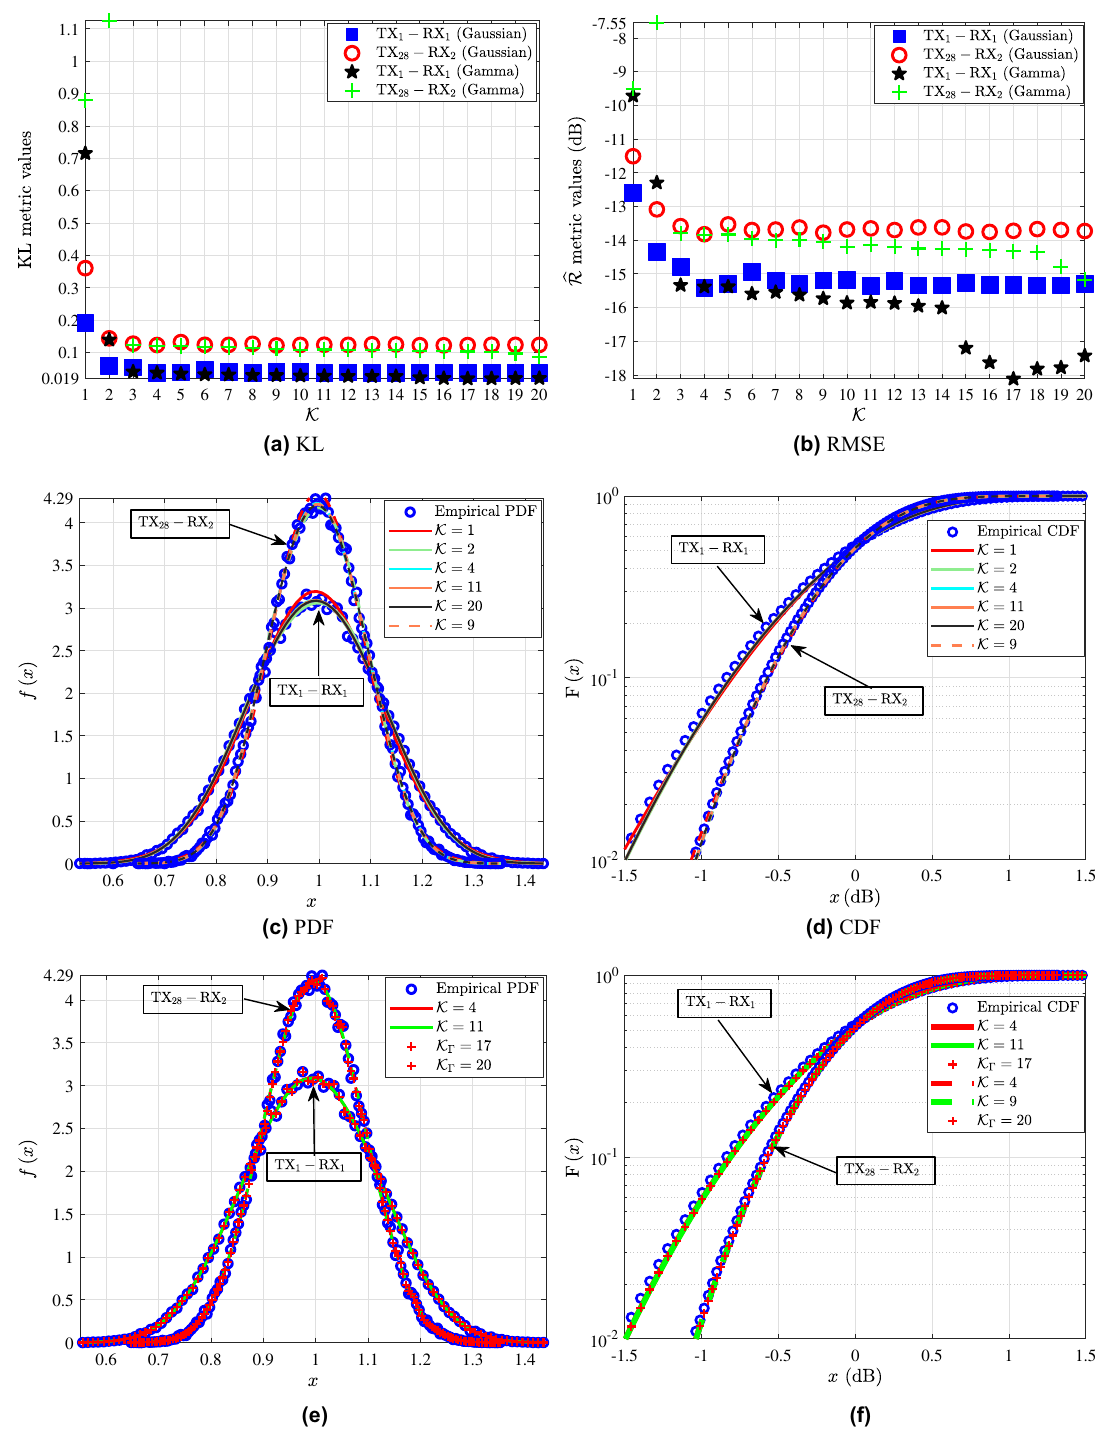
RX 2 : ( a ) KL and ( b ) RX 1 and TX 28 R metrics for different values of K for the GMs and MGs. Figure 2. TX 1 − − ( c ) Fitting of the PDF and ( d ) CDF analytical GM expressions to the empirical channel gain data. ( e ) Fitting of the PDF and ( d ) CDF of the best fitting analytical GM and MG expressions to the empirical channel gain (cid:31)